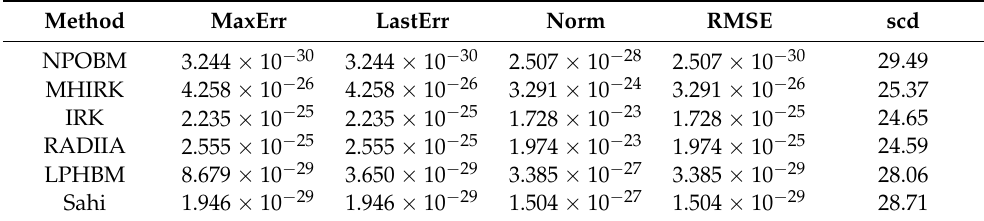
Table 3. Numerical results for Problem 1 with NS = 10 4 where x ∈ [ 0,2 ]